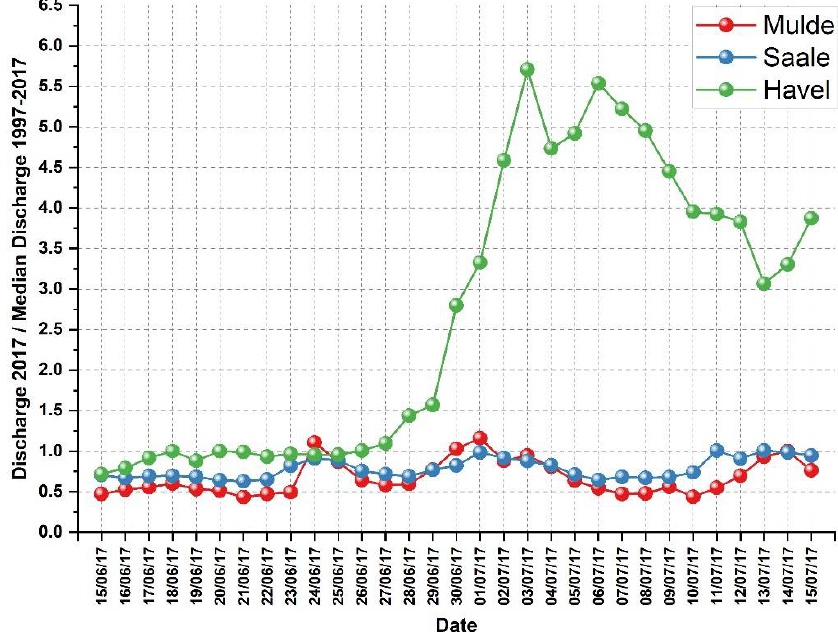
Figure 4. Normalized daily mean discharge of the tributaries Mulde (Bad Düben), Saale (Calbe- Griezehne) and Havel (Havelberg) from 15 June to 15 July 2017. The respective median of the daily mean discharge between 1997 and 2017 was used to normalize the mean discharge rates of each day. The data were acquired from the Elbe Data Information System (FIS) [24] of the River Basin Community Elbe (FGG Elbe).